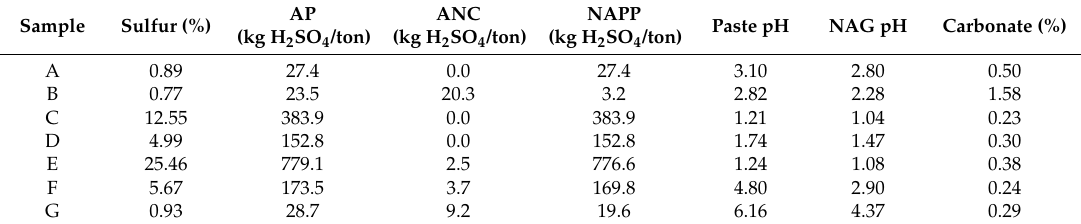
Figure 2. Sample X-ray diffraction (XRD) patterns. Ill: Illite, Ka: Kaolinite, Qz: Quartz, Ja: Jarosite, Py: Pyrite, Al: Albite, Si: Siderite, and Mu: Muscovite. Table 1. Summary of the sulfur content, and results of the acid–base accounting (ABA), net acid generating (NAG), paste pH, and Bernard calcimeter tests. AP: acid potential, ANC: acid neutralizing capacity, NAPP: net acid producing potential, NAG pH: net acid generating pH.